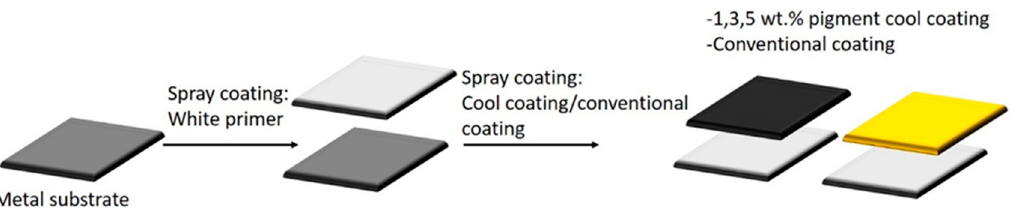
Table 1. Dry film thickness of each